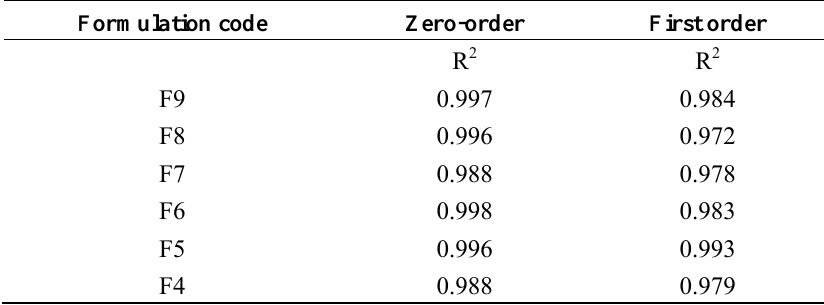
Table 4. Kinetics of in vitro release of carvedilol from the asymmetric membrane